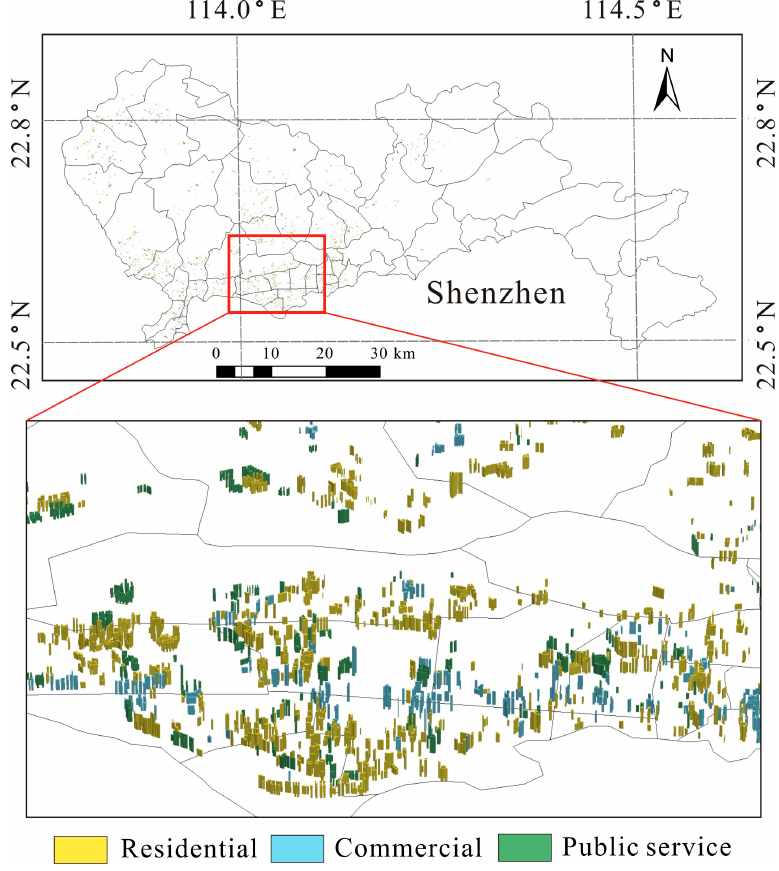
Figure 2. Location of Shenzhen and distribution of tall buildings.